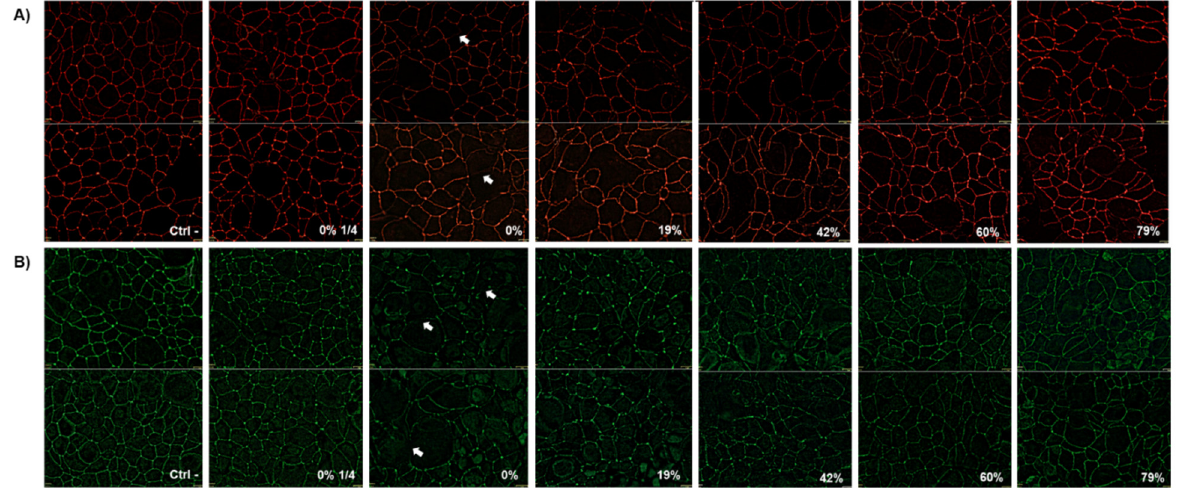
Figure 6. Immunofluorescence staining of ( A ) zonula occludens − 1 (ZO-1) and ( B ) occludin in B11 oral keratinocytes 24 h after being challenged by raw or deacidified (0, 19, 42, 60, and 79%) cranberry juice for 5 min. Images from two independent experiments are presented.